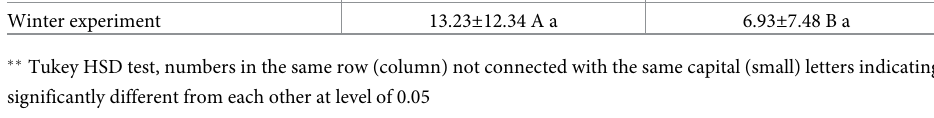
significantly different from each other at level of 0.05